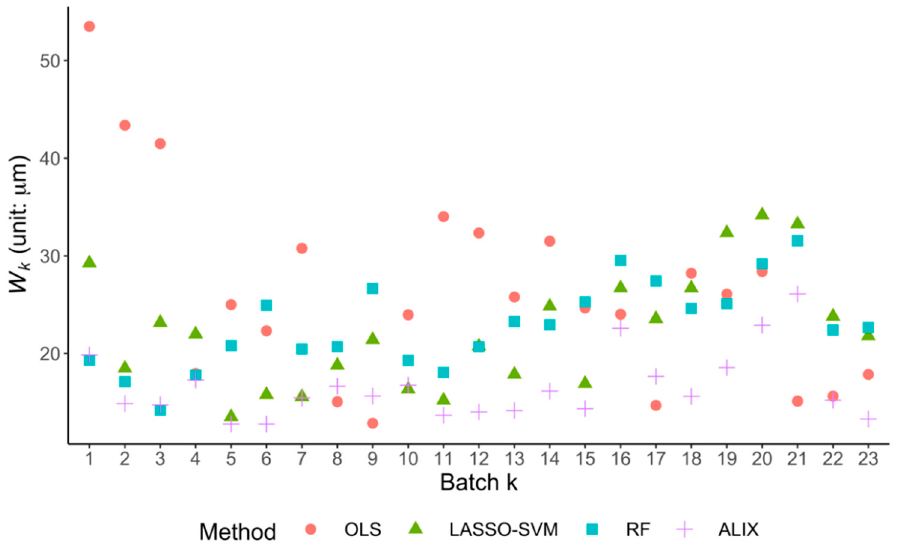
Figure 10. Results of W k for each model that is trained on batch k .